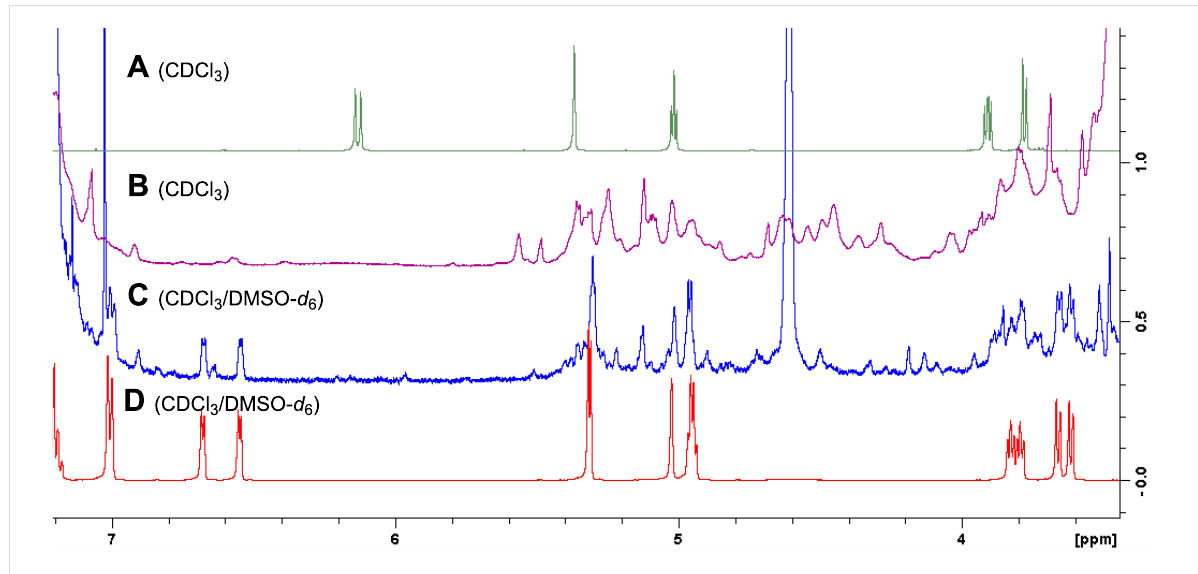
Figure 2: 1 H NMR spectra (500 MHz) of 1 (A), 1:1 1 /PhCHO reaction mixture at 1 h at 60° C (B), mixture after 24 h at 60 °C (C), and product 5a (D). DMSO-